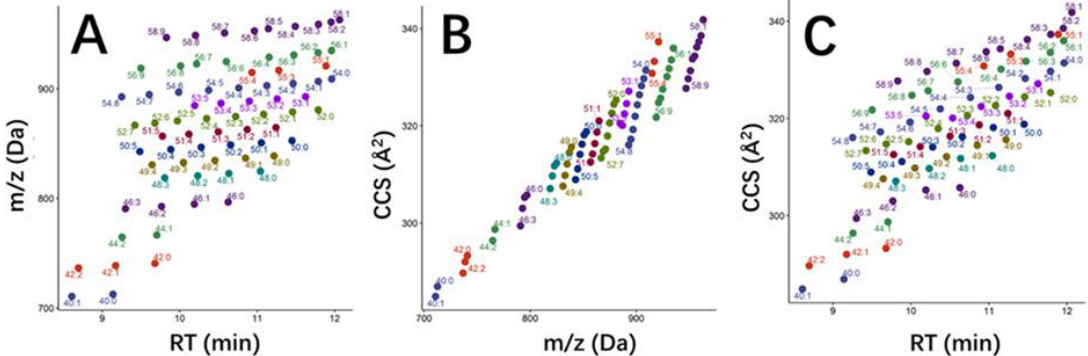
Figure 3. Selected triacylglycerides found in milk and comparison of the measured orthogonal parameters: ( A ) m/z vs. retention time (RT), ( B ) collision cross section (CCS) vs. m/z , and ( C ) CCS vs. RT. Figure reprinted with permission from [44]. Copyright (2018) American Chemical Society.